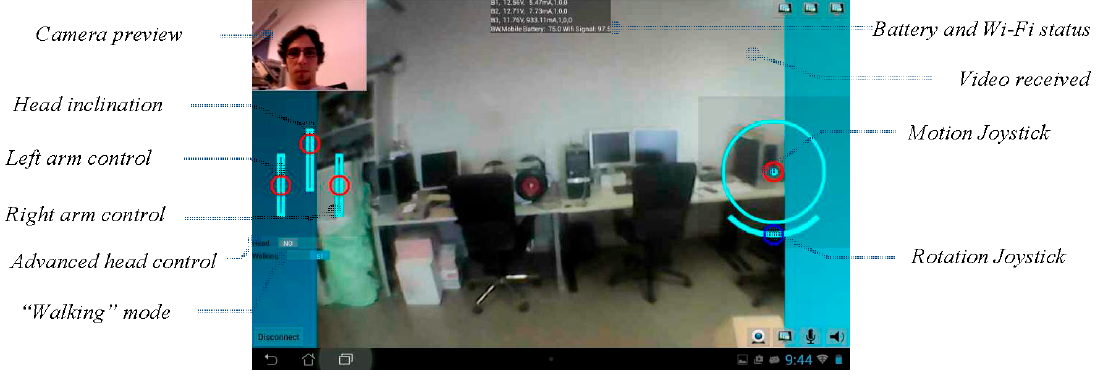
Figure 15. Screenshot of the remote telecontrol application.